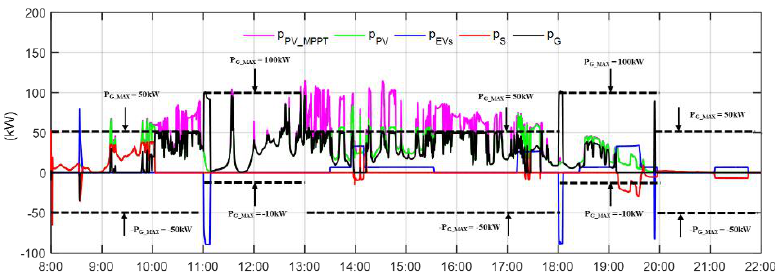
Figure 11. Power flow of DC microgrid under ICDA.